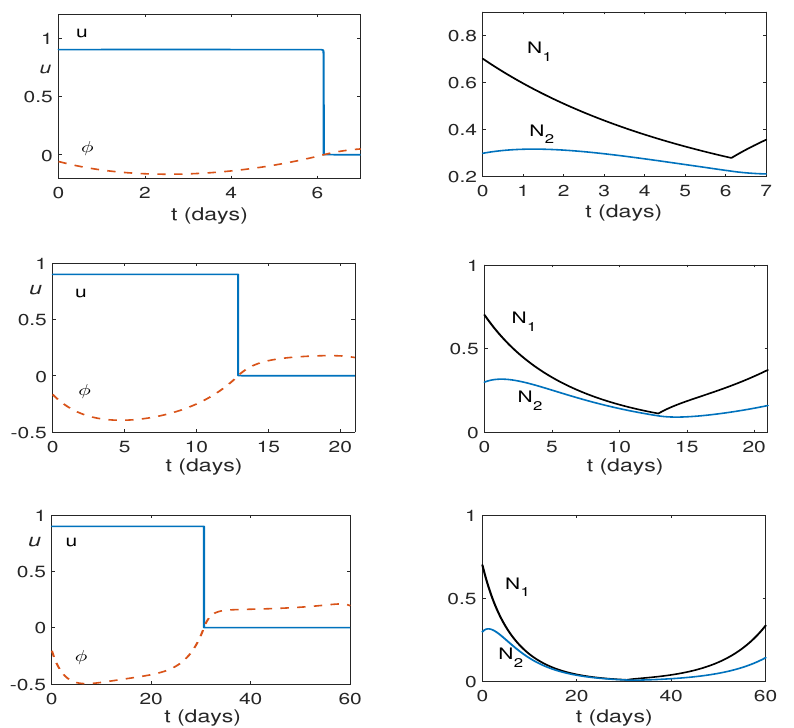
Fig. 2 Examples of locally optimal controls (left) and their corresponding trajectories (right) for T = 7 (top), T = 21 (middle) and T = 60 (bottom) for the parameter values given in Table 1.